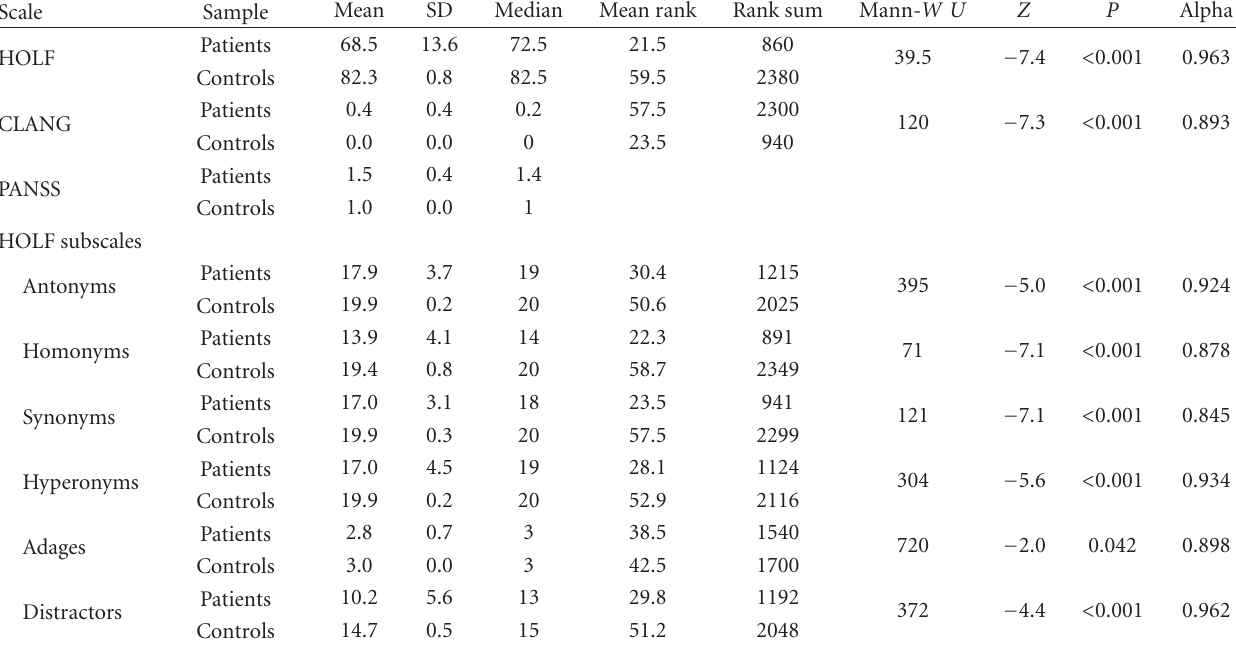
Table 1: Statistics of HOLF, CLANG, and PANSS by subsample (patients N = 40; controls N =